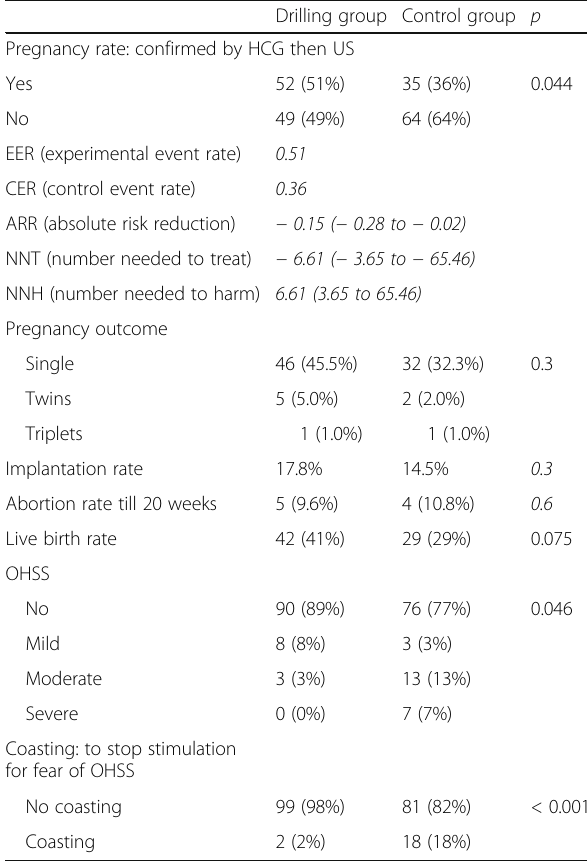
Table 3 Pregnancy outcomes and OHSS Drilling group Control group